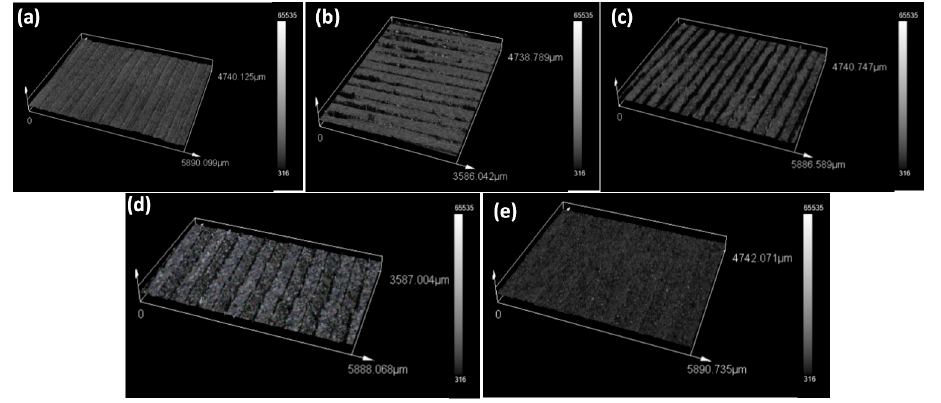
Figure 10. 3D surface topography for ( a ) OTS, ( b ) waste, ( c ) 2% Mg, ( d ) 4% Mg, and ( e ) 8% Mg prints.